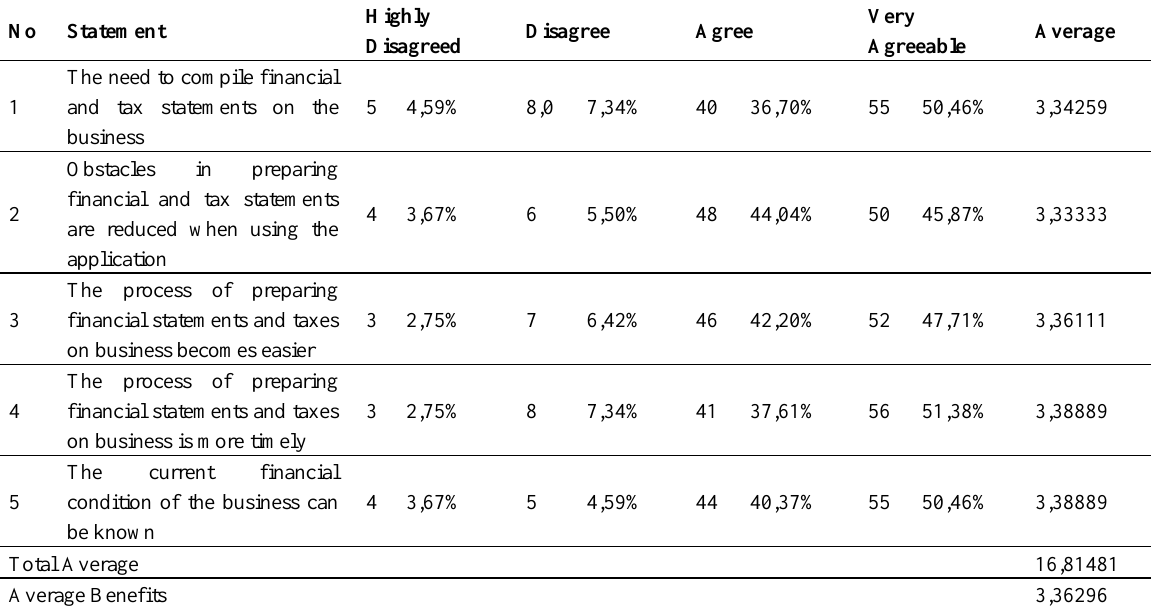
Table 4: While the average benefits are as